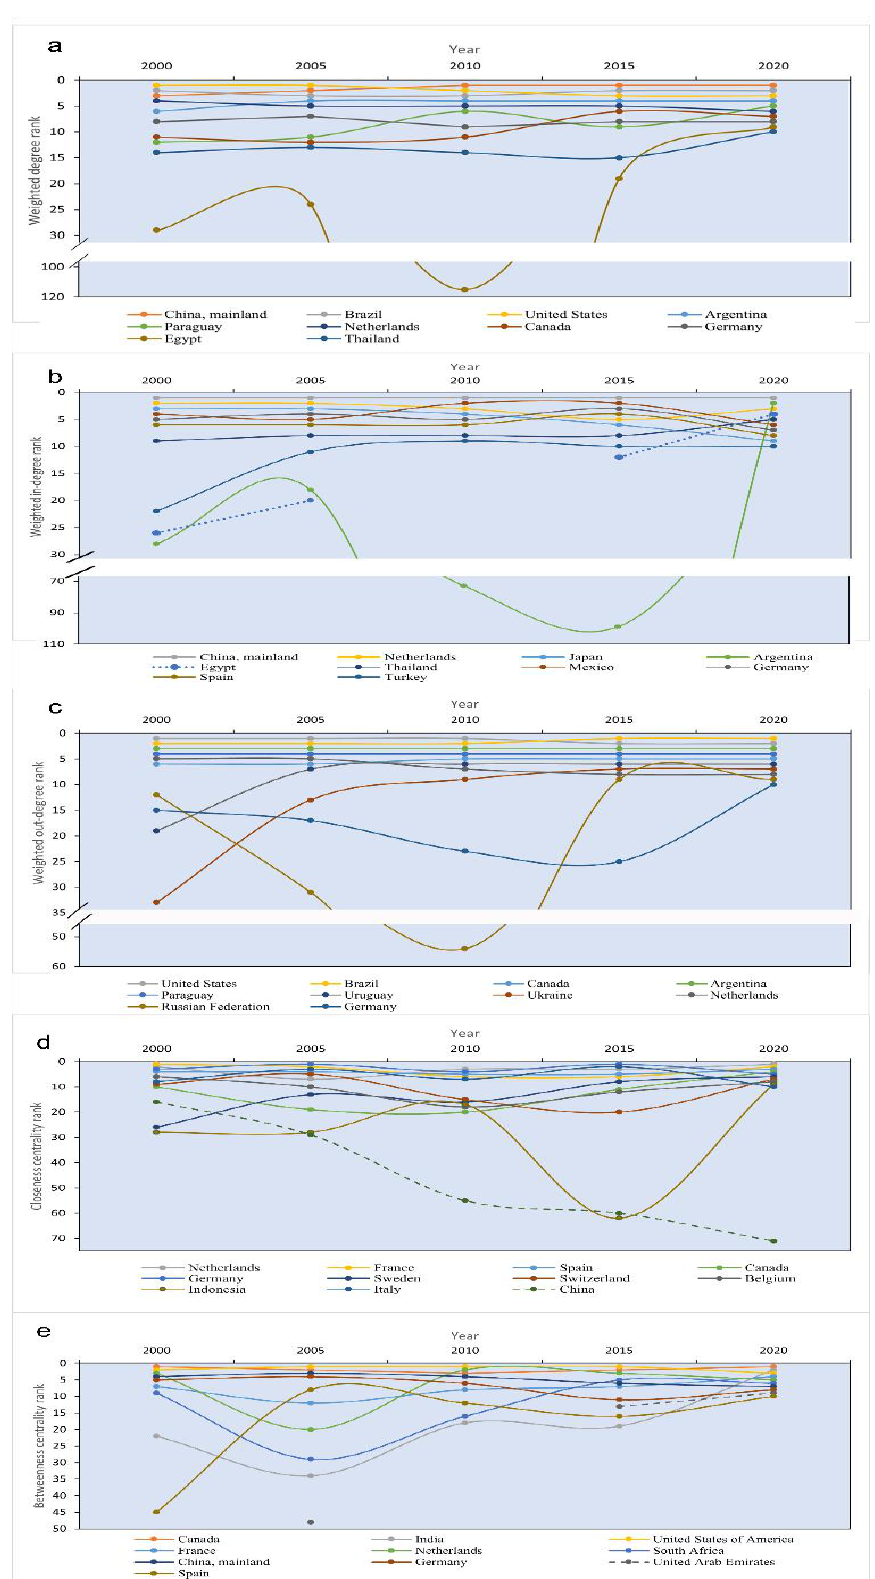
Figure 3. Dynamic rankings of the top-ranked countries (data source: FAO). ( a ) Weighted degree; ( b ) weighted indegree (due to the missing import data, Egypt was specifically indicated by dotted lines); ( c ) weighted outdegree; ( d ) closeness centrality; and ( e ) betweenness centrality.